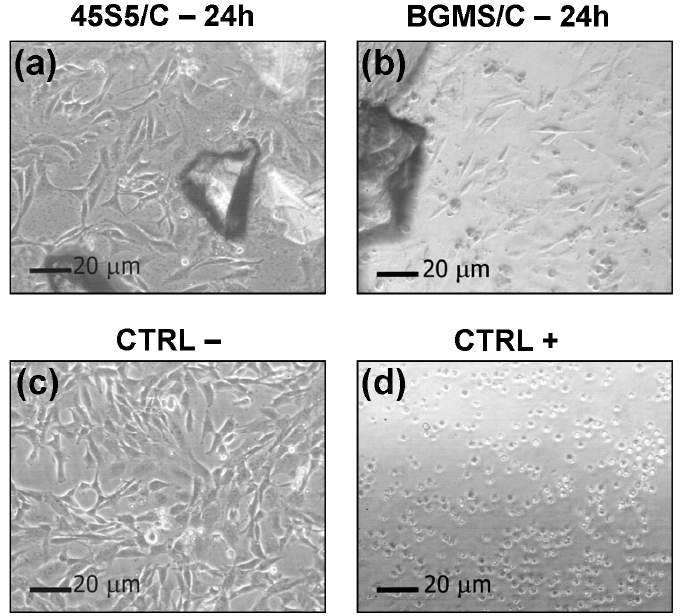
Figure 2. The morphology of NIH/3T3 cells after 24 h direct contact (optical microscope). ( a ) 45S5/C; ( b ) BGMS/C; ( c ) CTRL-; ( d ) CTRL+.